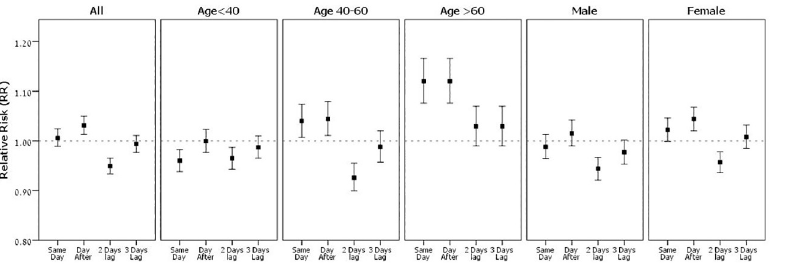
Fig 1. Relative Risk (RR) for daily ED visits for headache associated with daily rating percent, among age groups and by male and females. Relative Risk (RR) and 95% Confidence Interval for ED visits per increase in 5 units of daily rating percentages. Results of the separated Poisson regression models, for study period 2002–2012, adjusted for public holidays.